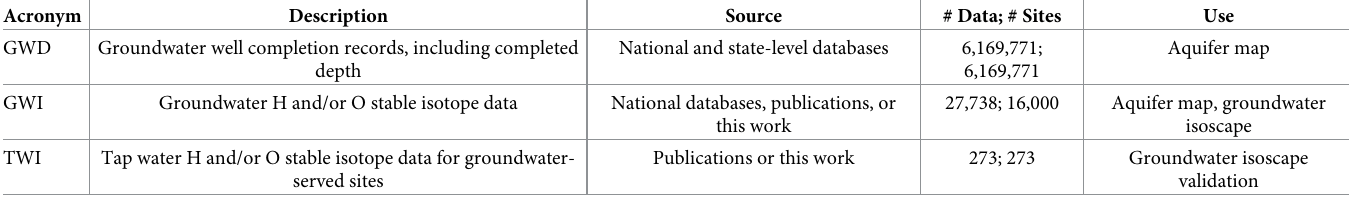
Table 1. Properties of the three primary datasets used in this